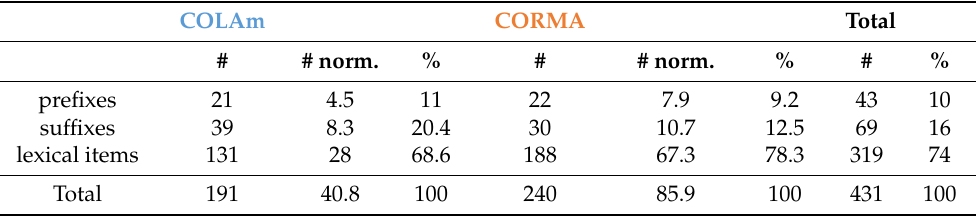
Table 3. Distribution of general categories of intensifiers per corpus. 15